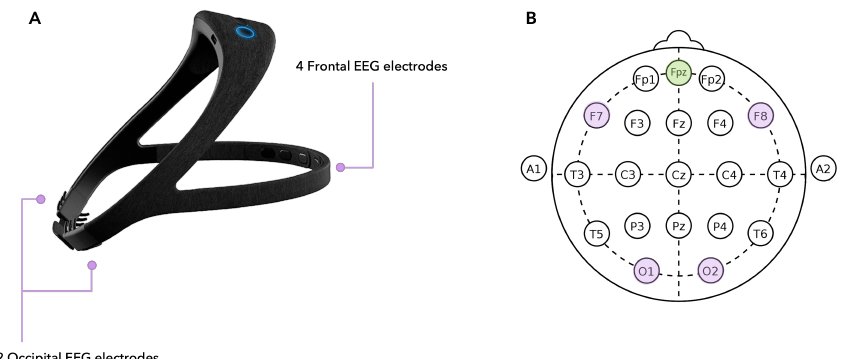
Figure 5. ( A ) Dreem 2 EEG Headset employed for the data collection and sensors location. ( B ) EEG electrodes available on the headset, 10–20 standard (green: channel selected for the